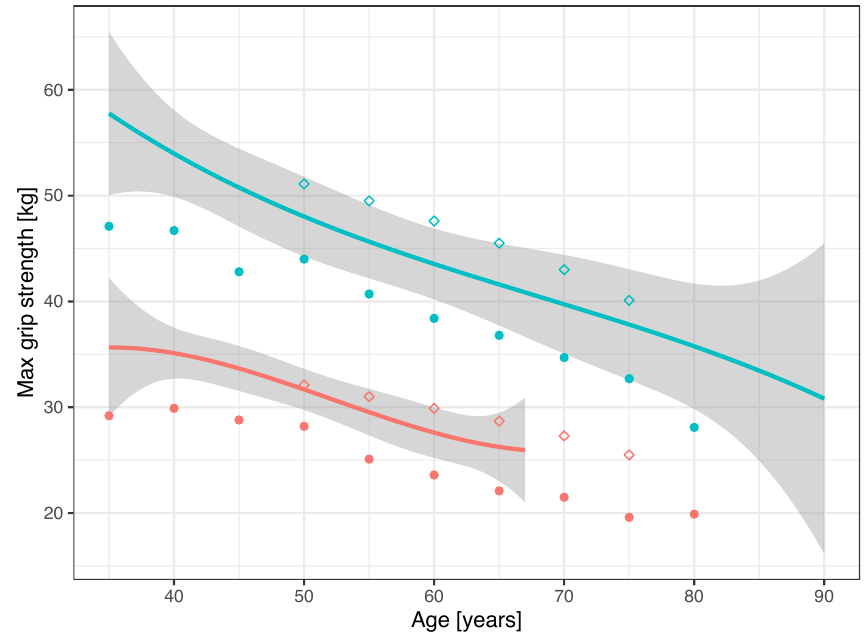
Figure 2. Age-associated decline in maximum GS for females (red) and males (green) with 95% confidence bands. Figure legend: weightlifters—solid lines; community-dwelling adults—closed circles; Senior Games athletes—open